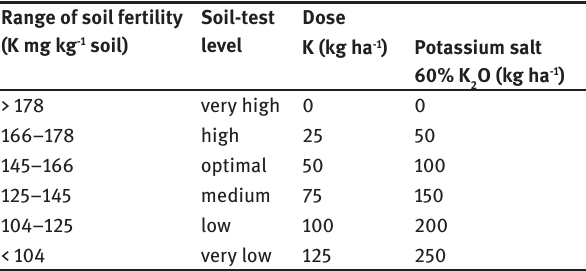
Figure 2: Soil sampling scheme in a 61-ha experimental field in Charbielin (heavy soil). Table 2: The range of content of the available K form in soil and the corresponding defined doses of